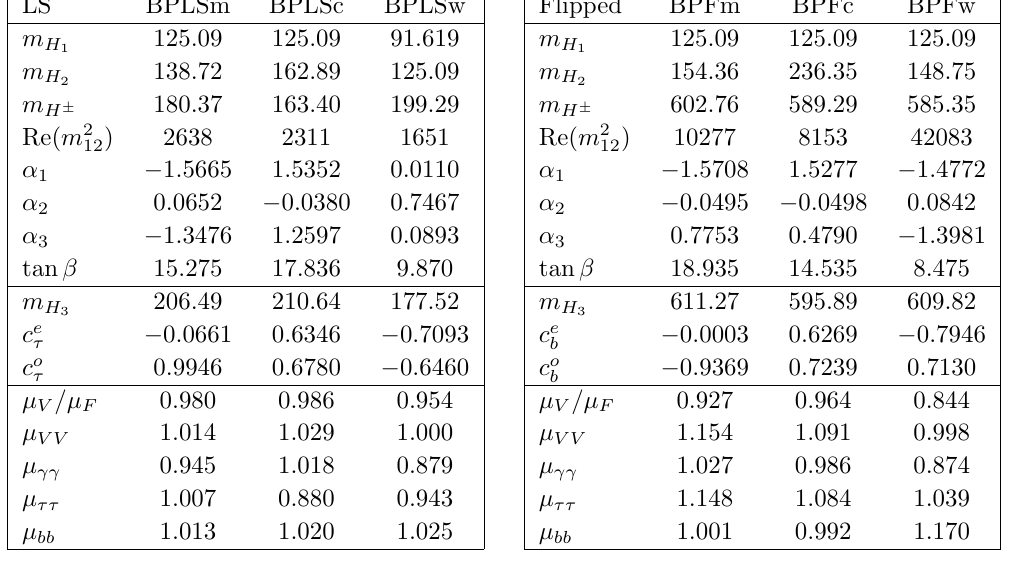
Table 4 . Benchmark points with large pseudoscalar Yukawa couplings in the Lepton-Speci(cid:12)c (LS) and Flipped types. Lines 1-8 contain the input parameters; lines 9-11 the derived third Higgs mass and the relevant Yukawa couplings (multiplied by sgn( c ( h ))) and the last (cid:12)ve lines the signal 125 V V strengths of h 125